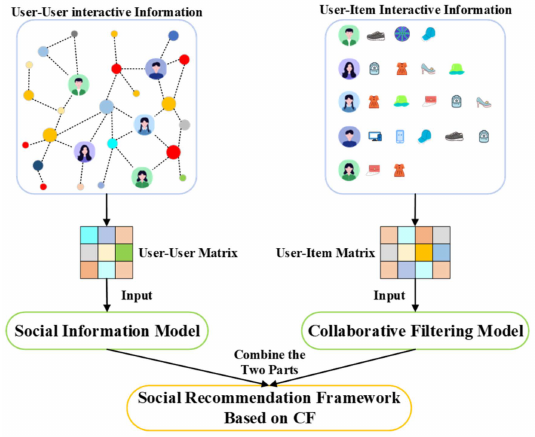
Figure 1. Social recommendation framework based on